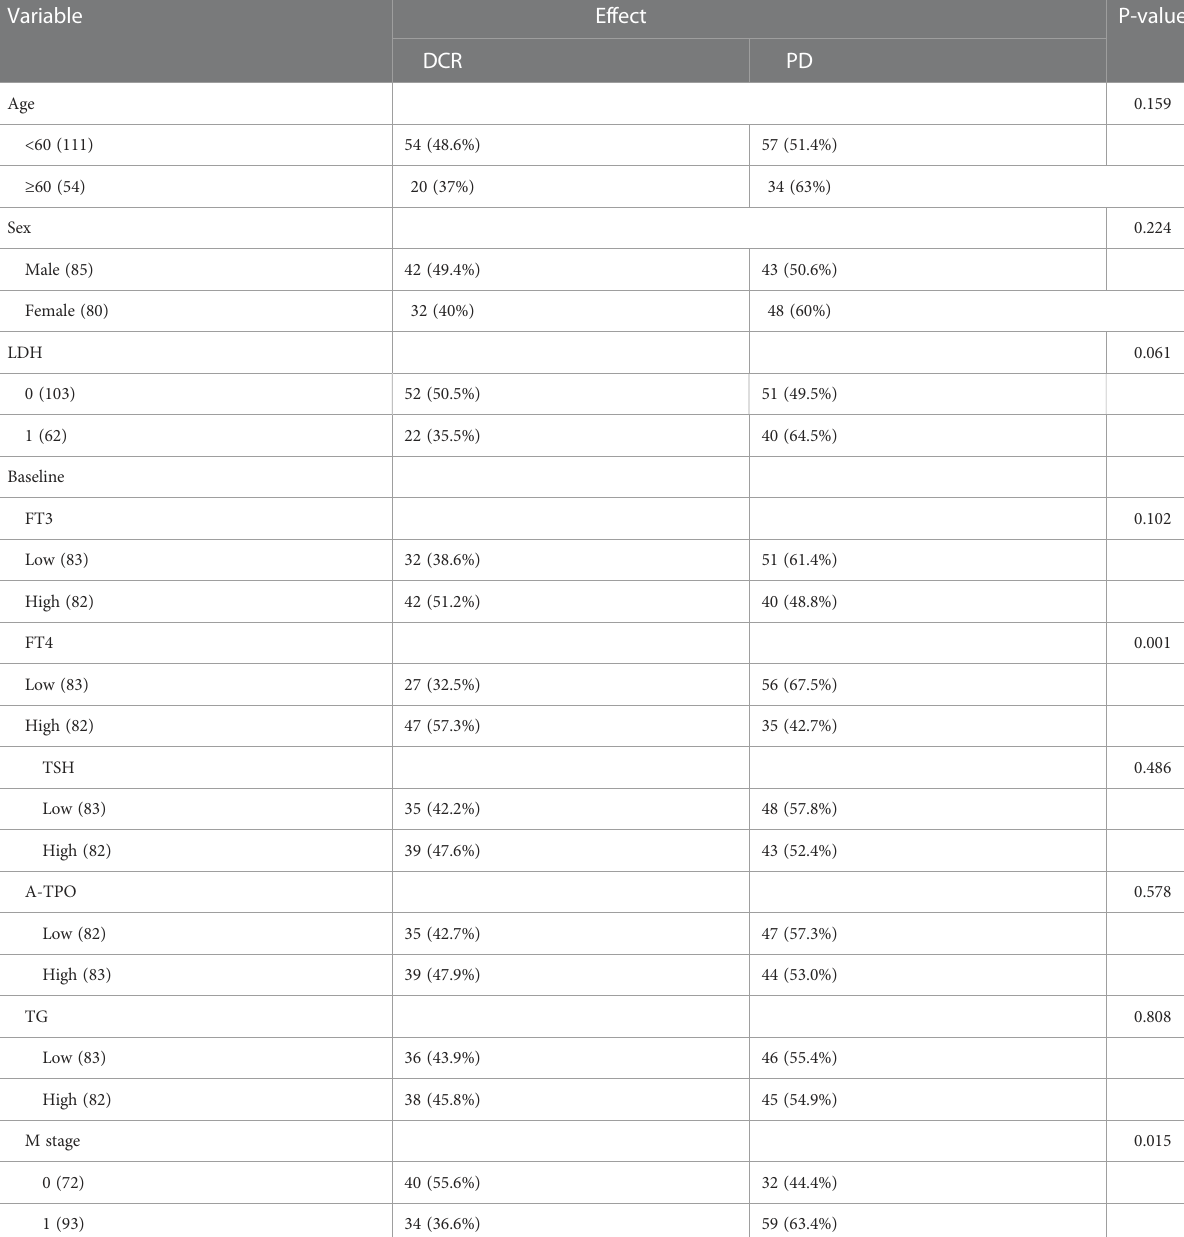
TABLE 2 The association of ef fi cacy of PD-1 blockade therapy with several baseline predictor variables.